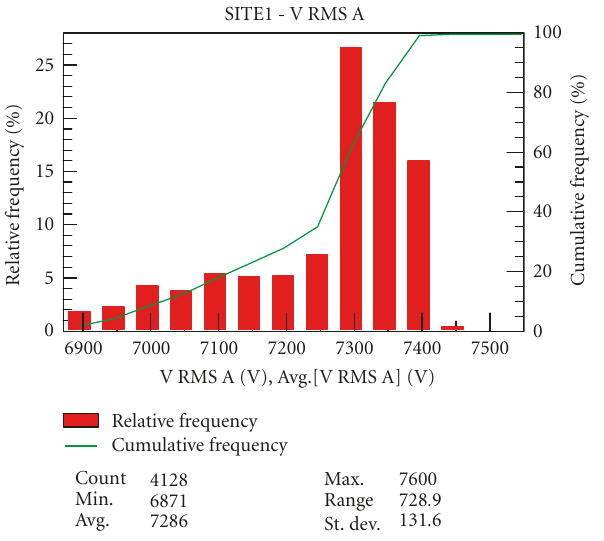
Figure 2: Histogram representation of RMS voltage indicates the statistical distribution of the RMS voltage